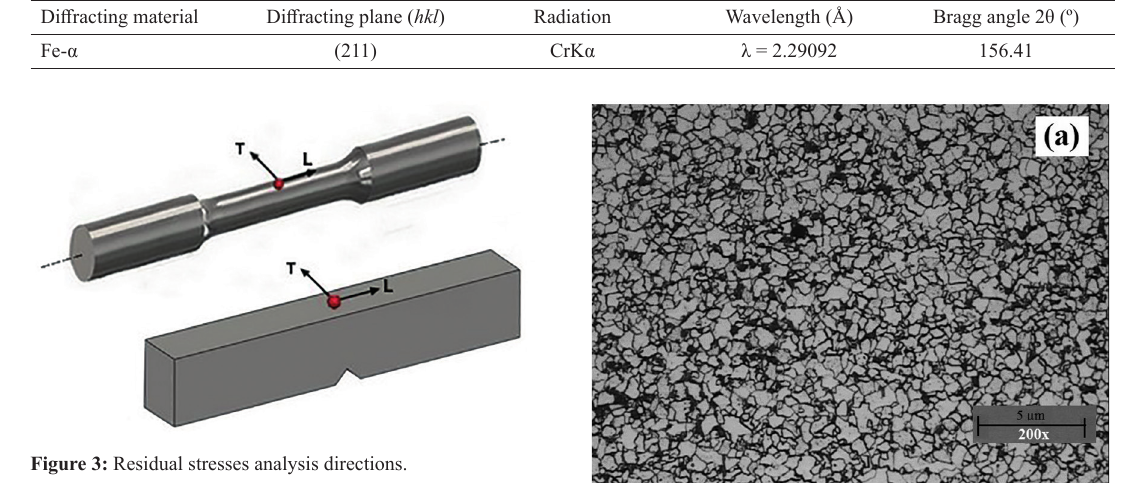
Table 3: Parameters used for the X-ray analysis.